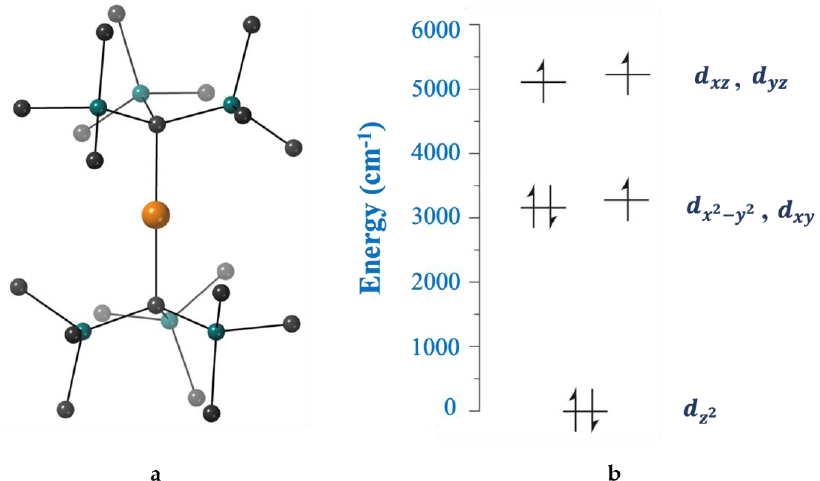
Figure 10. ( a ) The molecular structure of the anion that is present in 15 . ( b ) Energy splitting of the 3d orbitals of [Fe I {C(SiMe 3 ) 3 } 2 ] − derived from an ab initio computational analysis; this orbital scheme is the origin of a strong magnetic moment along the z axis. Color code: Fe dark orange, Si turquoise, C black. H atoms have been omitted for clarity. Modified from reference [96].